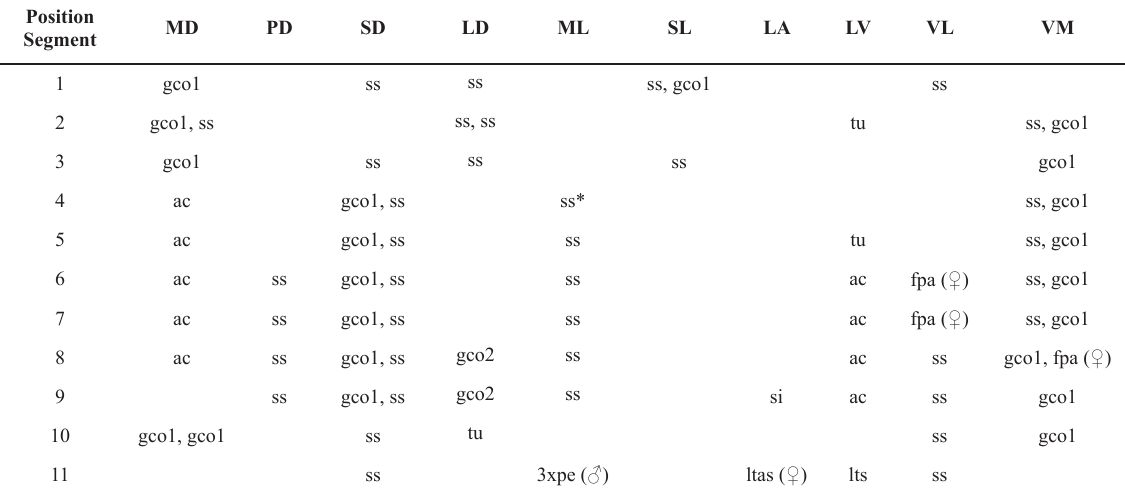
Table 18. Summary of nature and location of sensory spots, glandular cell outlets, tubes and spines arranged by series in Echinoderes chandrasekharai Sørensen & Chatterjee sp. nov. Position